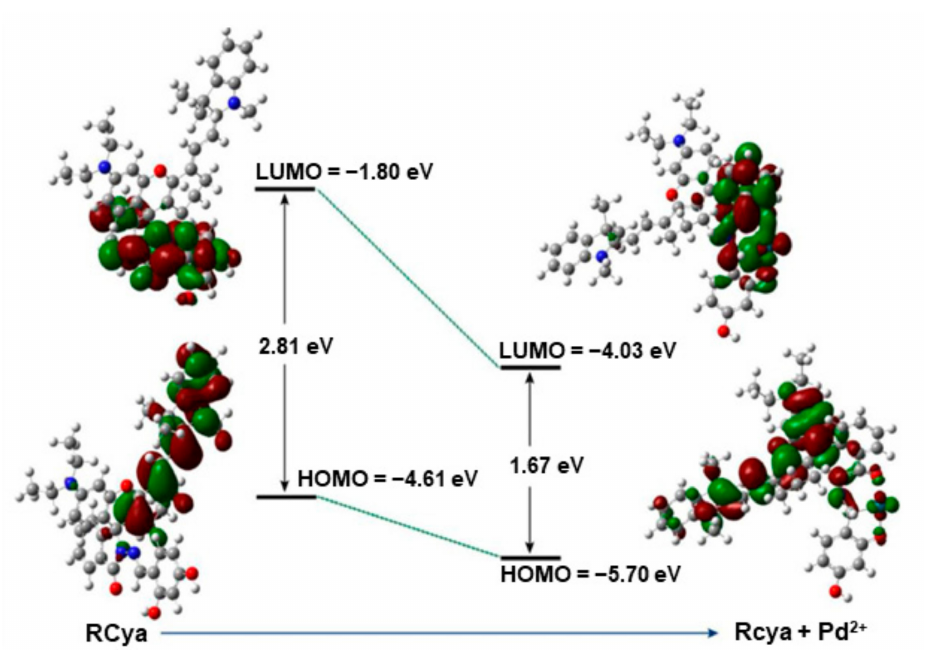
Figure 7. Density functional theory theoretical calculation for the combination of Rcya and Pd 2+